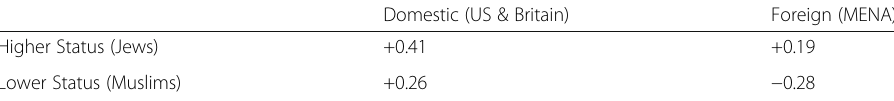
Table 5 Relative Tone of Coverage Based on Group Status and Geographic Setting Domestic (US &